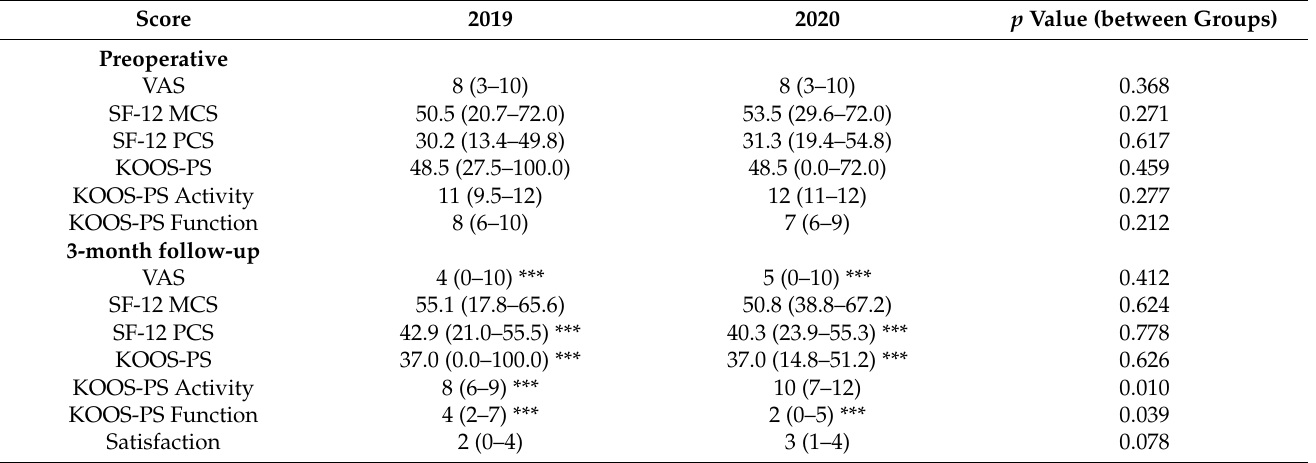
Table 3. PROMs in TKA